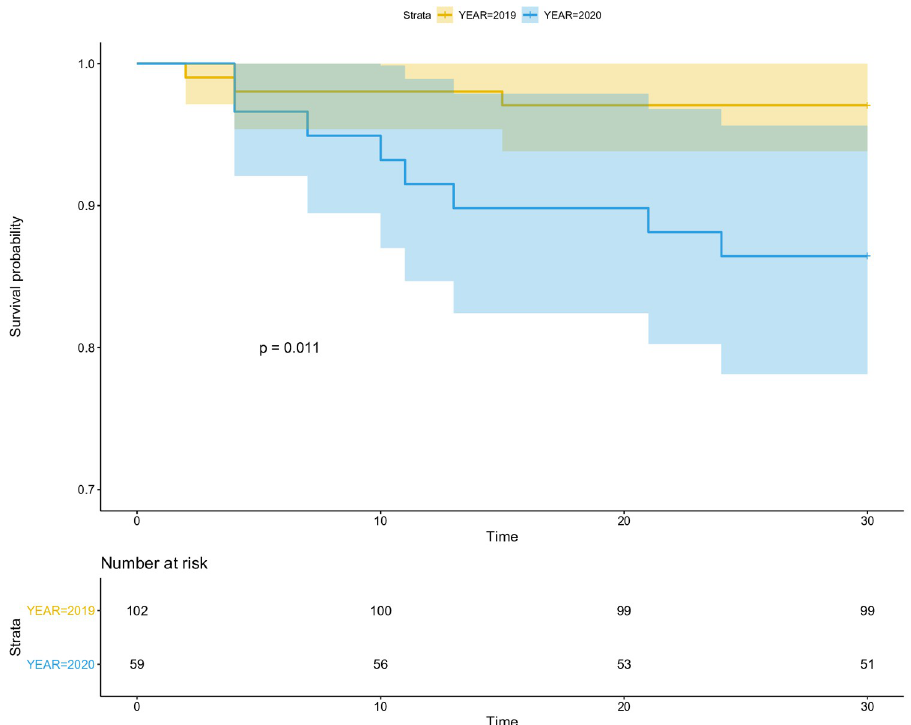
Fig 1. Comparative Kaplan Meier curves for the overall 30-day mortality, in 2019 and 2020. Significant difference in the 30-day mortality between 2019 and 2020.